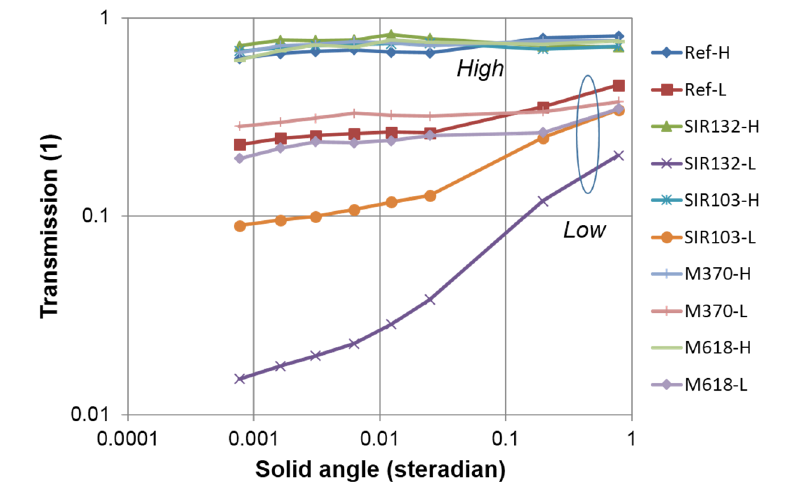
Figure 5. Transmission dependence on the solid angle. High and H data were measured at 50 V and low and L data are measured at 0 V. Wavelength: 1.523 μ